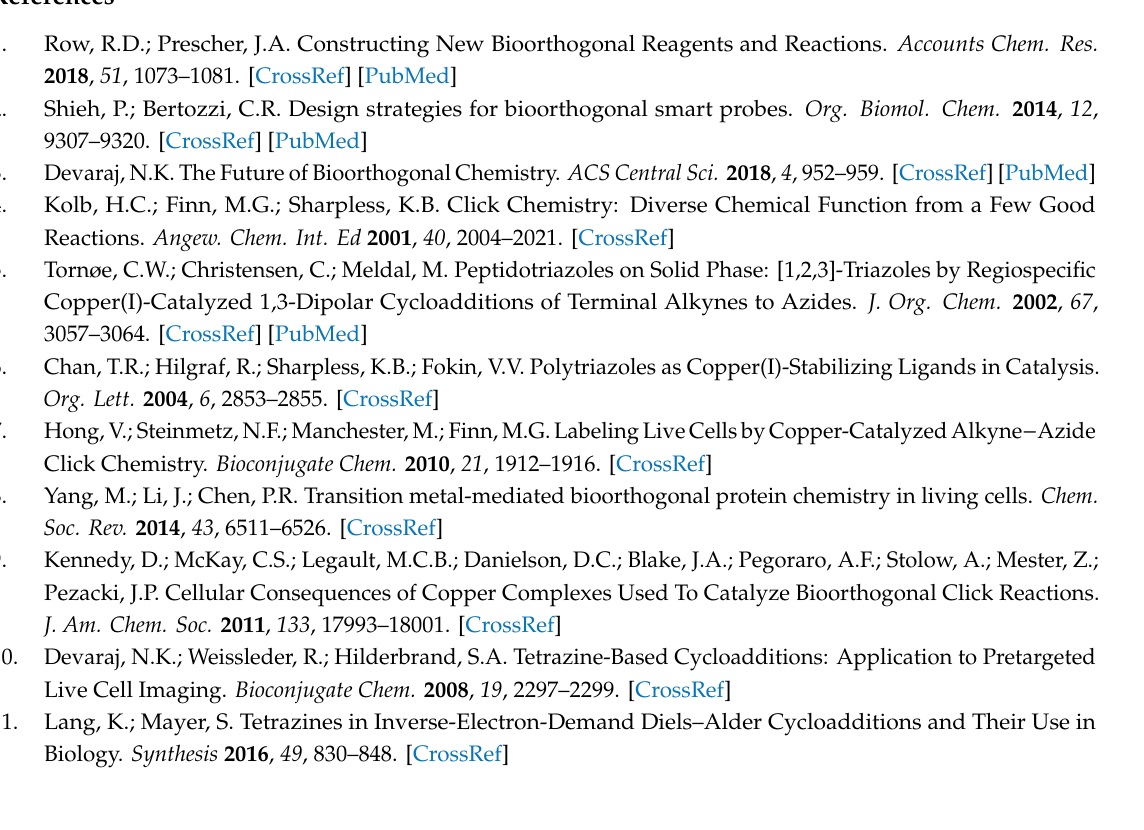
Figure S56. UV / vis absorbance of “photoclicked“ RNA2 dye adducts (reaction with 1.50 equiv. dye-maleimide) after purification. c AF647 = 1.20 µ M ˆ = 48% yield, c AF555 = 2.10 µ M ˆ = 84% yield, c Cy3 = 0.77 µ M ˆ = 31% yield. Figure S57. Fluorescence of “photoclicked” RNA2 dye adducts (after reaction with 1.50 equiv. dye-maleimide) after purification. c AF647 = 1.20 µ M, c AF555 = 2.10 µ M, c Cy3 = 0.77 µ M. Figure S58. UV / vis absorbance of “photoclicked“ RNA1 -Cy3 adduct (reaction with 10.0 equiv. Cy3-maleimide) after purification. c Cy3 = 1.76 µ M ˆ = 70% yield. Figure S59. Fluorescence spectrum of “photoclicked” RNA2 -Cy3 adduct (reaction with 10.0 equiv. Cy3-maleimide) after purification. c Cy3 = 1.76 µ M. Figure S60. UV / vis absorbance of A, C, G, U and 6 in comparison. Table S1. Molar extinction coe ffi cients of the natural bases and the artificial nucleoside 6